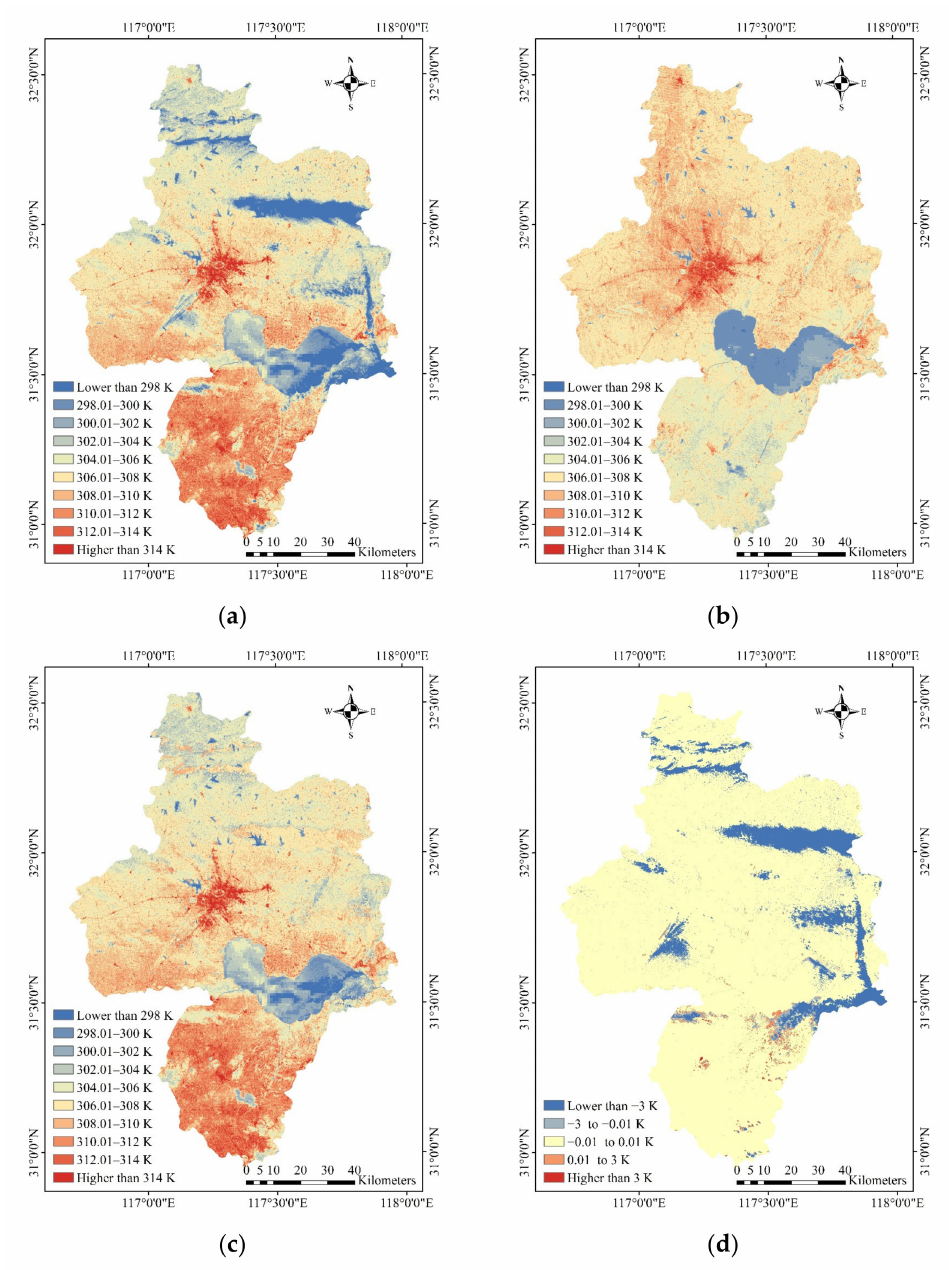
Figure 12. Reconstruction of LST product from different processing steps, date: 11 May 2003: ( a ) estimated LST; ( b ) simulated LST; ( c ) reconstructed LST; and ( d ) estimated LST— reconstructed